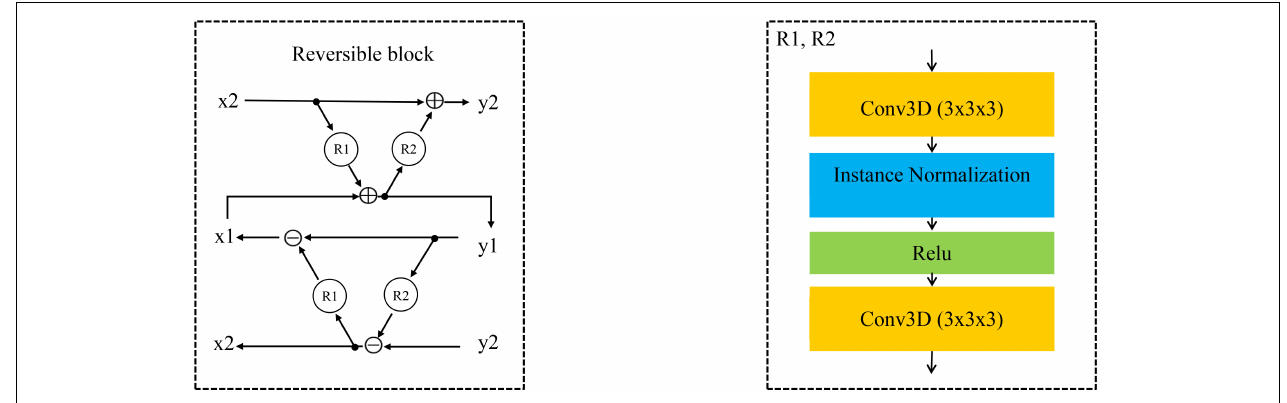
FIGURE 5 | The reversible block is composed of R1 and